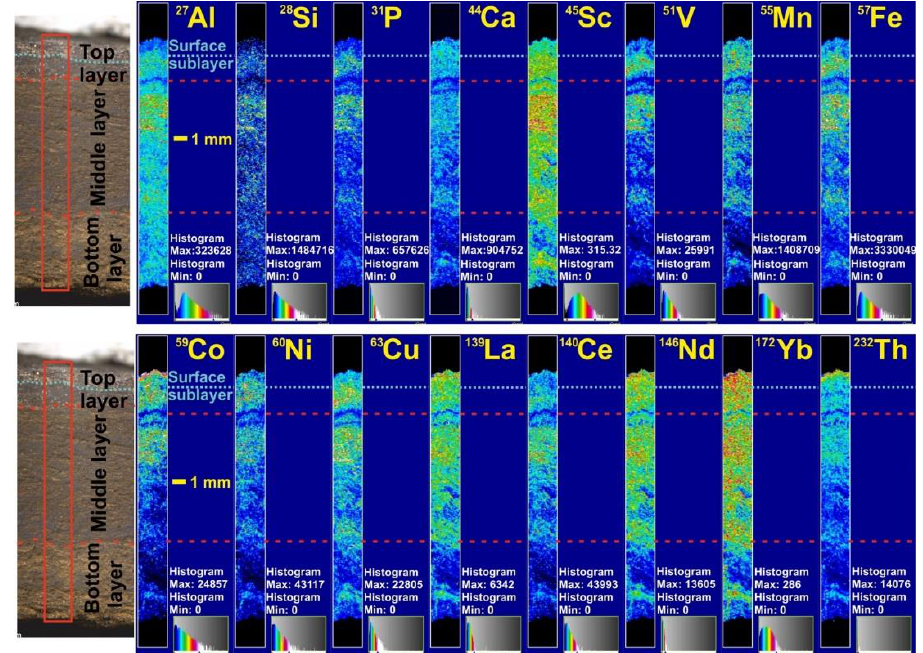
Figure 3. Al, Si, P, Ca, Sc, V, Mn, Fe, Co, Ni, Cu, La, Ce, Nd, Yb, and Th distribution through Mendeleev crust 648 stratigraphy using LA-ICP-MS.